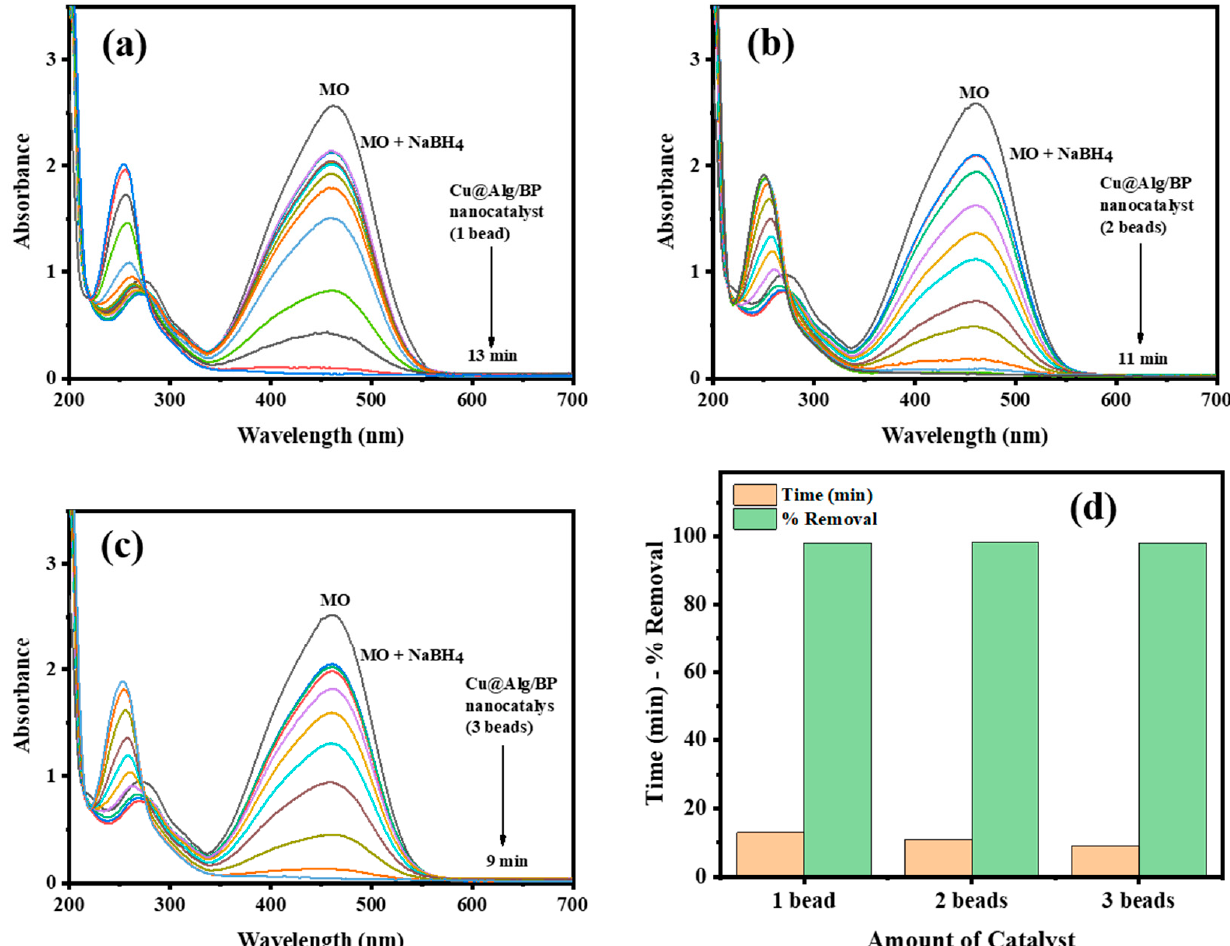
Figure 6. Time-dependent UV–vis spectra for MO reduction by NaBH 4 using ( a ) 1 bead; ( b ) 2 beads; ( c ) 3 beads of Cu@Alg/BP nanocatalyst. ( d ) Comparative relation of % removal and time required for MO reduction using nanocatalysts.